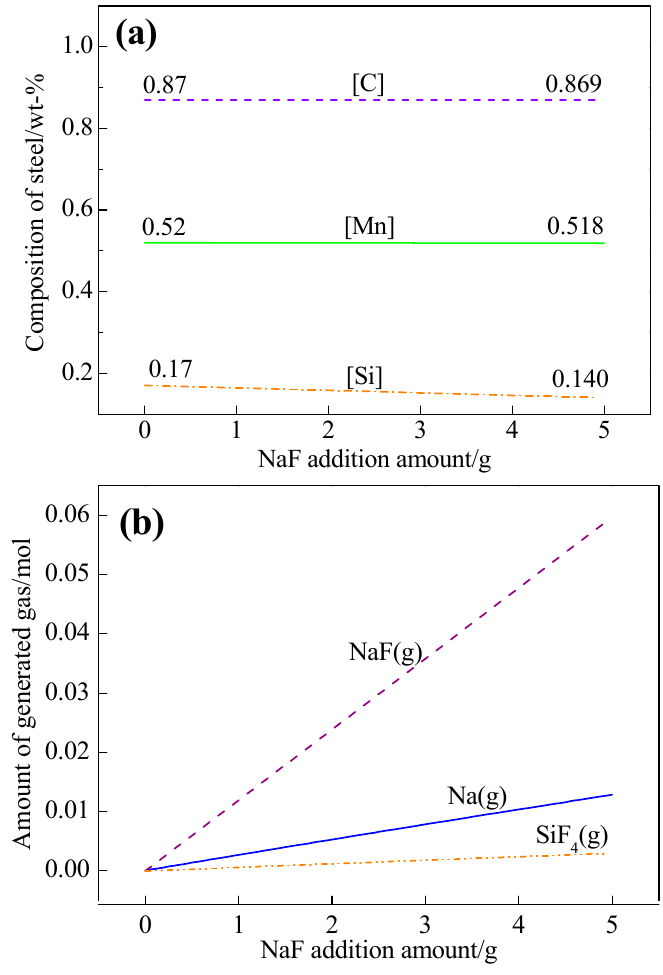
Figure 2. Gas generation after NaF addition in liquid steel at 1823 K. Calculated results using FactSage 7.2. ( a ) Composition change of steel with NaF addition; ( b ) amount of generated gas with NaF addition.